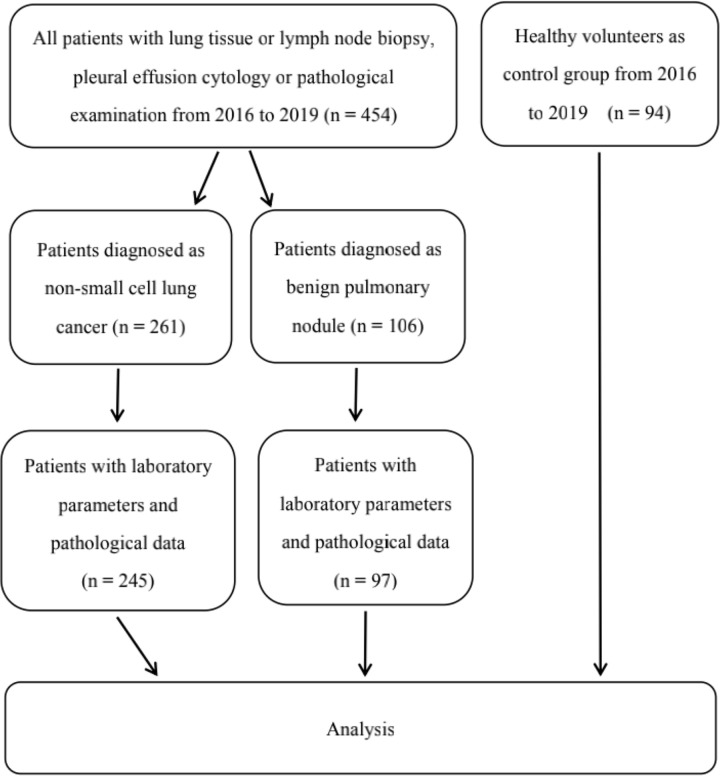
The flow chart of the study.